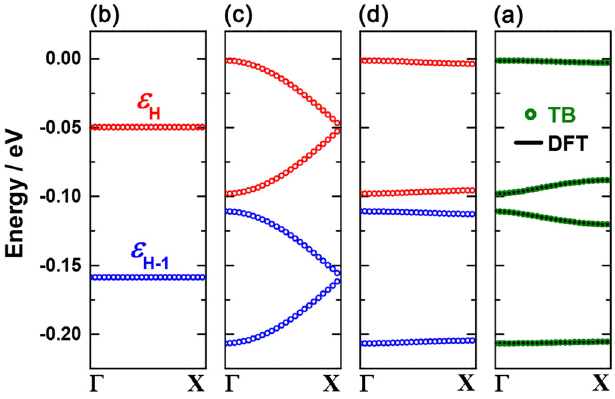
Fig. 3 Tight-binding (TB) band structure along Γ → X of the spiro- OMeTAD crystal with different values of the model parameters (see TB Values in Table S3): a full parameters; b site energies only; c site energies and average values of transfer integrals associated with HOMO and HOMO-1; d full parameters except for zero cross electronic couplings. The DFT band structure is also displayed in a . The crystallographic coordinates of Γ and X are (0, 0, 0) and (0.5, 0, 0), respectively; the Fermi level is taken as reference (set at zero) Fig. 4 Schematic diagrams of a the molecular packing and b the effective pathway for hole transport along the a direction of the spiro-OMeTAD crystal. In a , the dashed rectangle denotes the unit cell and the solid arrow represents the lattice constant ( a = 13.7